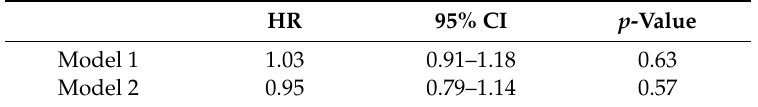
Figure 1. Distribution of hepcidin levels in the AtheroGene Study ( n = 2198). Table 2. Association of hepcidin per one SD increase with CV death and nonfatal MI during 4 years of follow ‐ up.